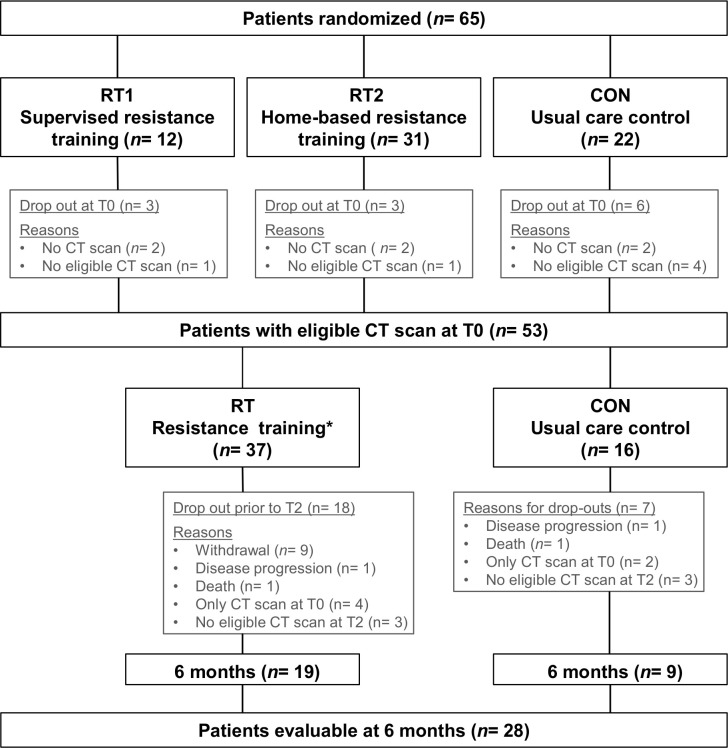
Patient flow chart.T0 = baseline; T2 = after 6-month resistance training; * Combining RT1 and RT2.